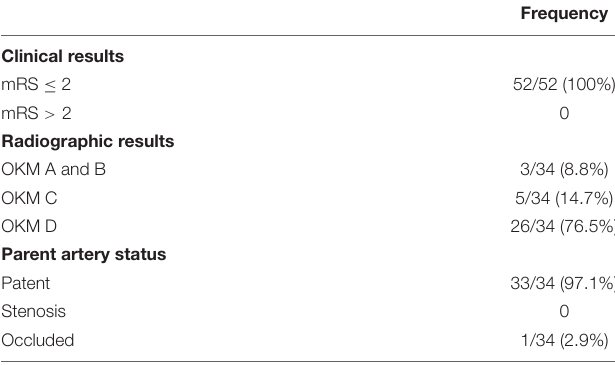
TABLE 4 | Radiographic and clinical results.